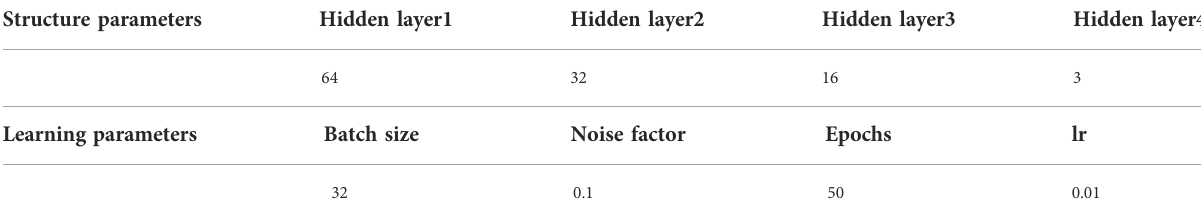
TABLE 3 Optimal parameters of LSTM-SDAE